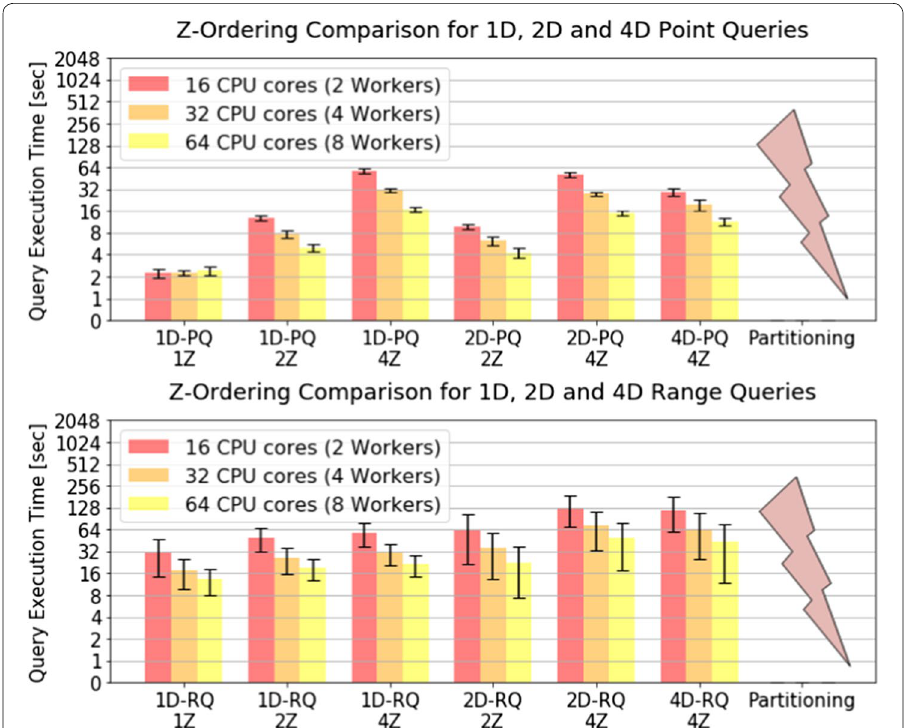
Fig. 7 Response times for Z-ordered attributes with cardinality of 10 6 . For instance, 2Z indicates that two attributes were used for Z-ordering. The flash symbol indicates that Spark was unable to create partitions using these attribute